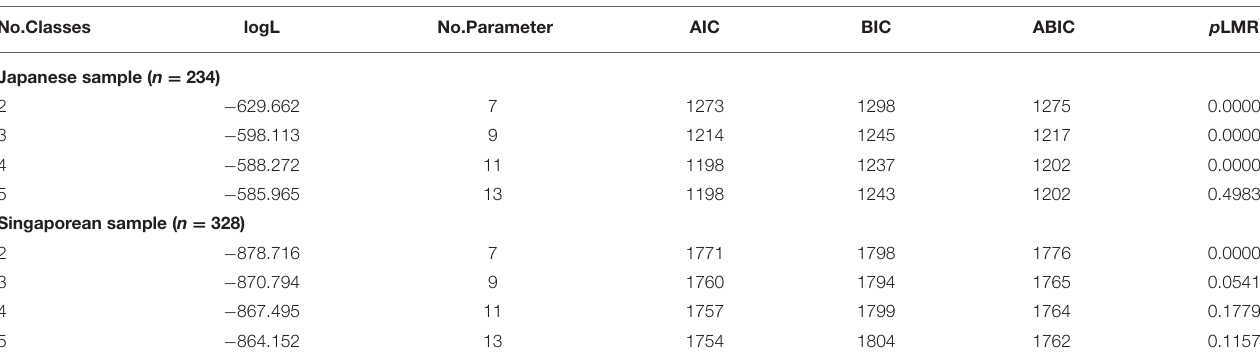
TABLE 3 | Goodness-of-fit statistics for LCFA models on different numbers of classes.